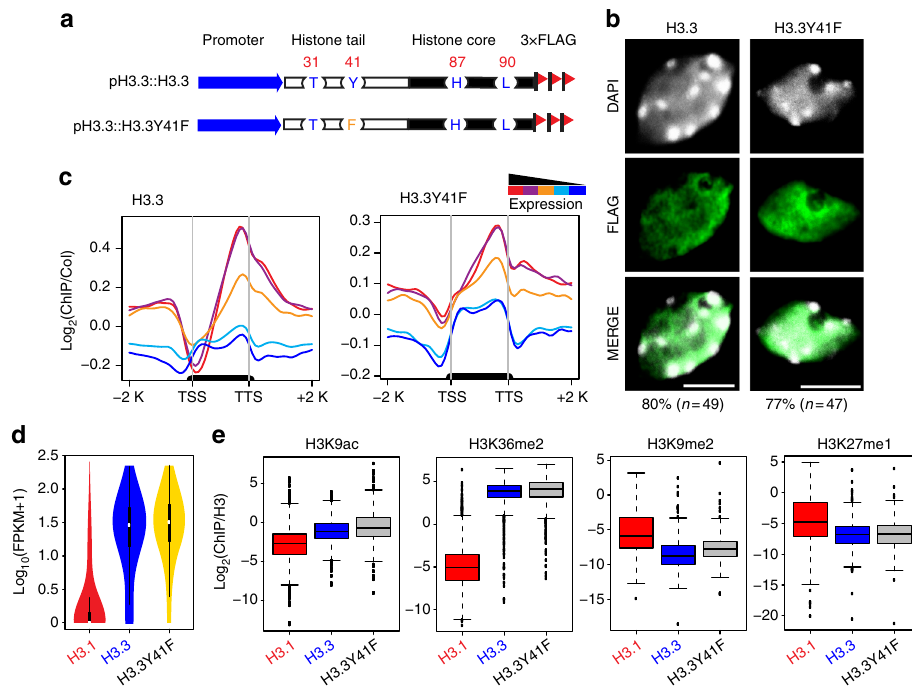
Fig. 2 Tyr41 is dispensable for H3.3 genomic distribution. a Schematic diagram of wild-type H3.3 and H3.3Y41F FLAG-tagged constructs. b Localization of wild-type H3.3 and H3.3Y41F protein in nuclei (bar = 5 μ m). The n represents the total number of examined nuclei. The percentage describes the ratio of the nuclei showing the H3 distribution pattern out of total examined nuclei. DAPI indicates the DAPI staining of the nucleus. c Metagene plots of wild-type H3.3 and H3.3Y41F ChIP-seq reads over fi ve groups of genes divided based on their expression levels. The black bar in the x -axis represents genes. TSS, transcription start sites; TTS, transcription terminal sites; − 2 K and +2 K represent 2 kb upstream of TSS and 2 kb downstream of TTS, respectively. The y - axis represents the log 2 value of H3.3 and H3.3Y41F ChIP-seq reads normalized to those of Col-0. d Violin plot showing the expression levels of genes associated with H3.1, H3.3, and H3.3Y41F ChIP-seq peaks. The y -axis represents the log 10 value of FPKM +1. FPKM, fragments per kilobase of transcript per million mapped reads. RNA-seq data were from 3-week-old seedlings. e Boxplots of histone modi fi cation levels over ChIP-seq peaks of H3.1, H3.3, and H3.3Y41F. The y -axis represents the ChIP-seq read density normalized by H3. Histone modi fi cation ChIP-seq data were from 2-week-old aerial